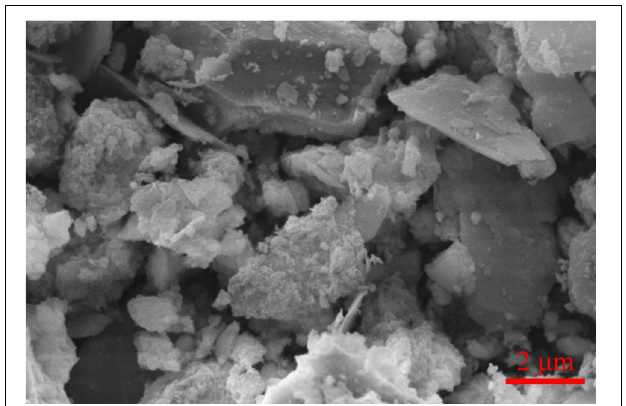
FIGURE 2 | Morphology of RP